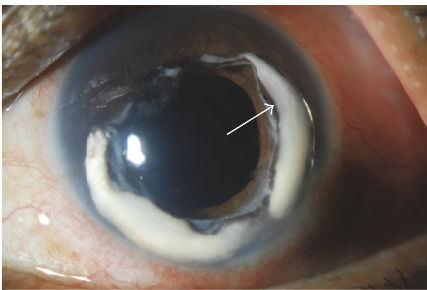
Figure 1: Slit lamp photograph of the right eye showing an incom- plete ring of milky white opaque cortical lens material, Soemmering ring, dislocated into the anterior chamber indicated by the